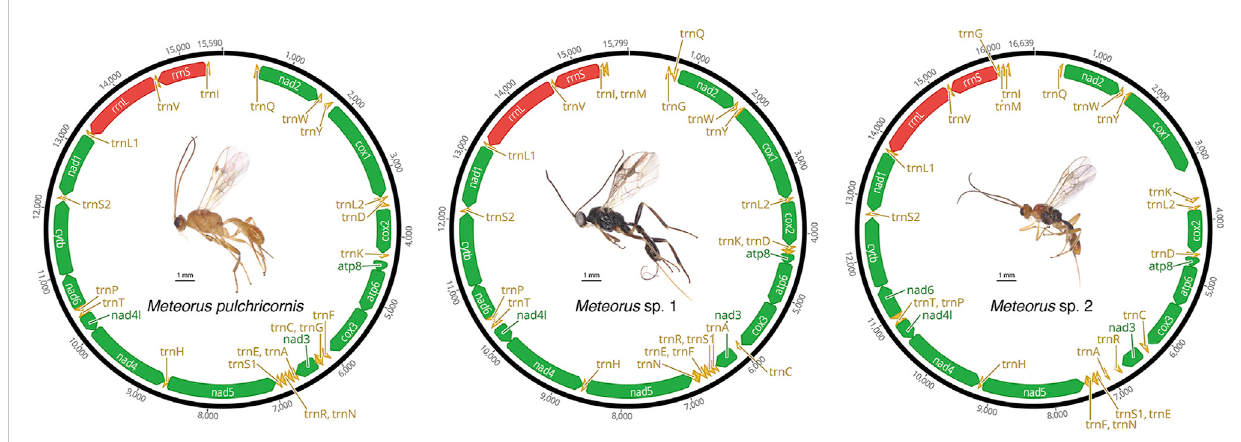
FIGURE 1 Mitochondrial maps of three Meteorus species.